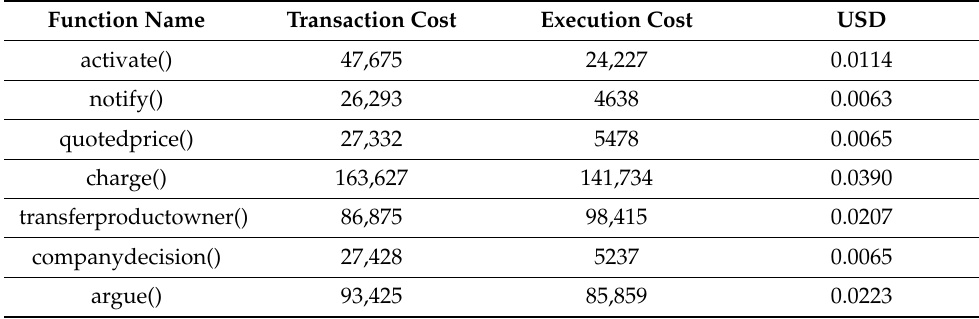
Table 2. The cost of function Gas used in smart